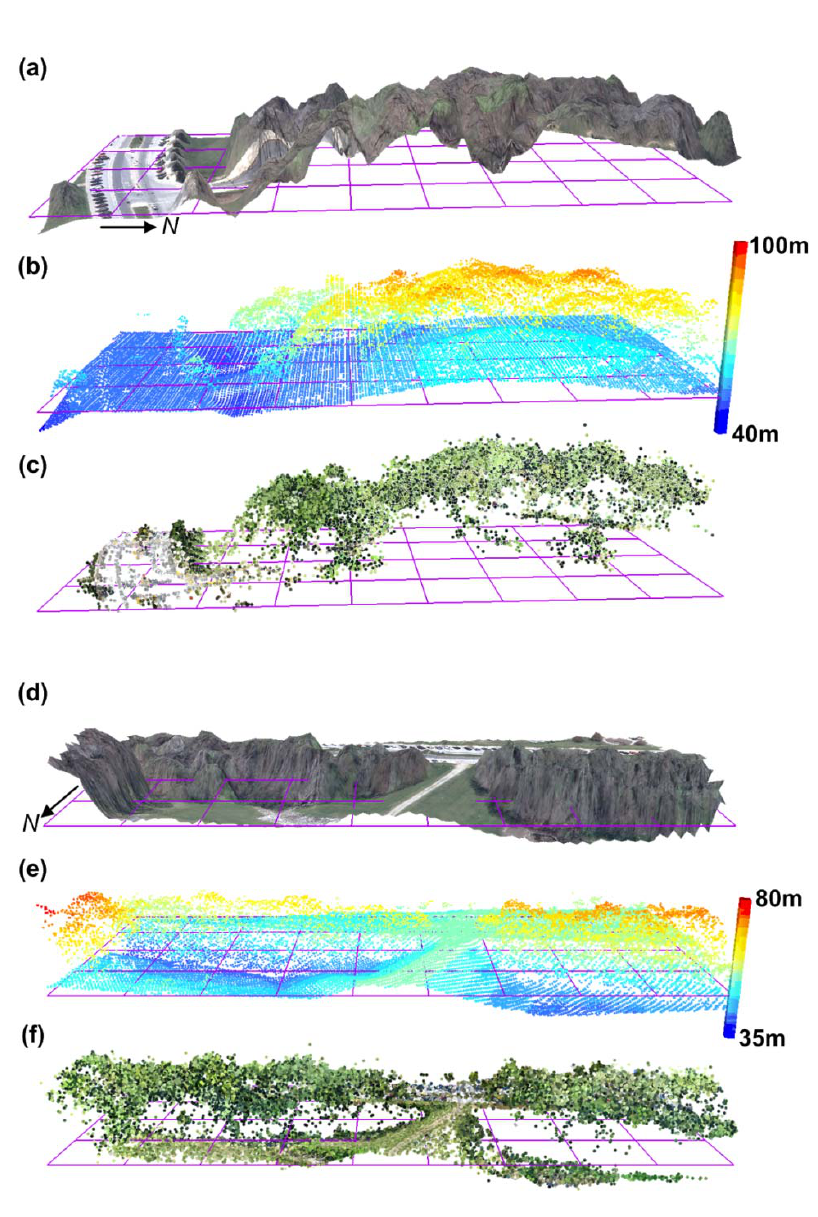
Figure 4. Oblique views of Ecosynth and LiDAR point clouds at the Knoll (Figure 1a)